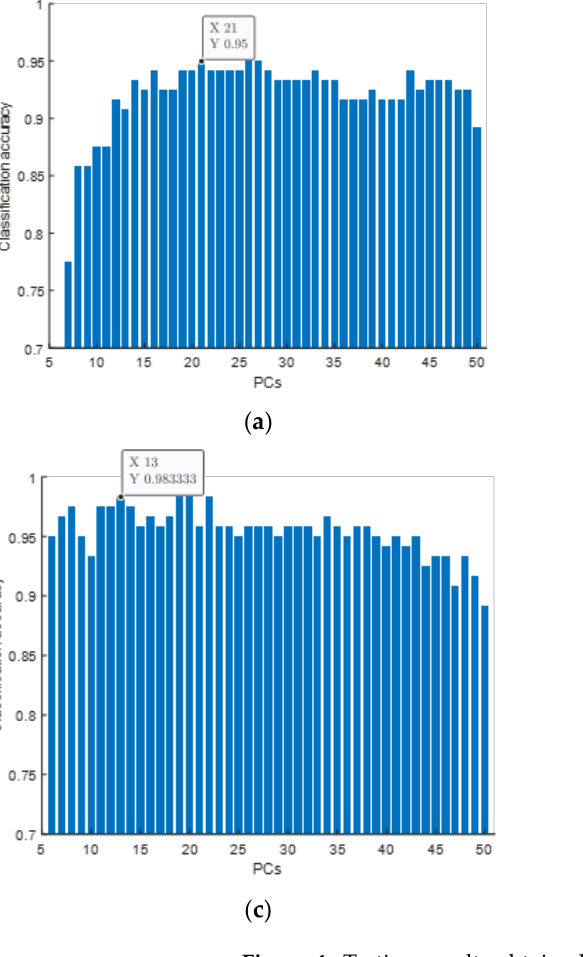
Figure 4. Testing results obtained using different models: ( a ) results from SVM; ( b ) results from PLS-DA; ( c ) results from PSO-SVM; ( d ) results from CLPSO-SVM.